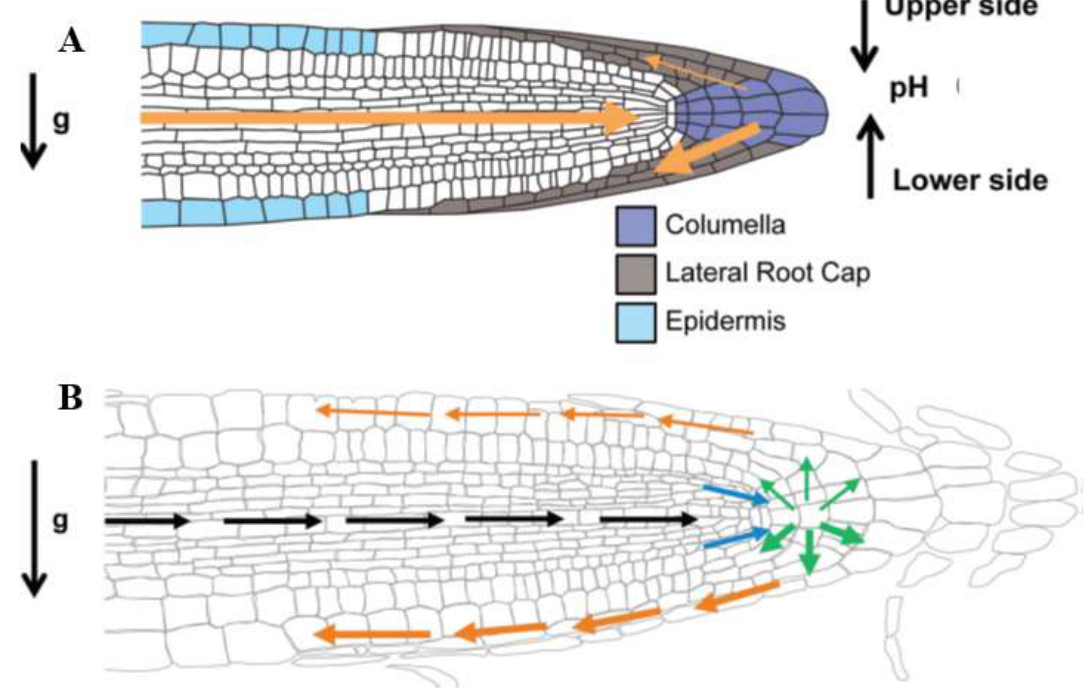
Figure 6. Reprinted with permission from Sato et al. [49]. Root gravitropism in Arabidopsis . ( A ) Gravity perception in Arabidopsis thaliana. At time point 0, roots grow vertically. After a 90° turn, the following events occur: (1) At 10 s, statoliths are still at the old bottom of the cell. After 3 min, statoliths move towards the new bottom of the cell to be uniformly distributed at 5 min [92]; (2) PIN3 and PIN7 relocalization is achieved 2 min after the gravity stimulus and, in consequence, a lateral auxin gradient is generated between the upper and lower side of the root (thin and thick orange arrows respectively) [100]; (3) the development of differential extracellular pH levels between the upper (acidic) and lower (alkaline) side of the gravistimulated root [51]; ( B ) Gravity signal transduction and transmission via auxin transport and redistribution. Black arrows show that AUX1 and PIN2 channel auxin from the shoot to the root tip. Blue arrows show how PIN4 distributes auxin efflux through the vascular tissue to the columella cells. PIN3 and PIN7 set up the auxin flow (green arrows), with an accumulation on the lower side of the root. PIN2 and AUX1 transport auxin through the lateral root cap to the epidermal cells in the elongation zone (orange arrows) where the actual growth response will occur.